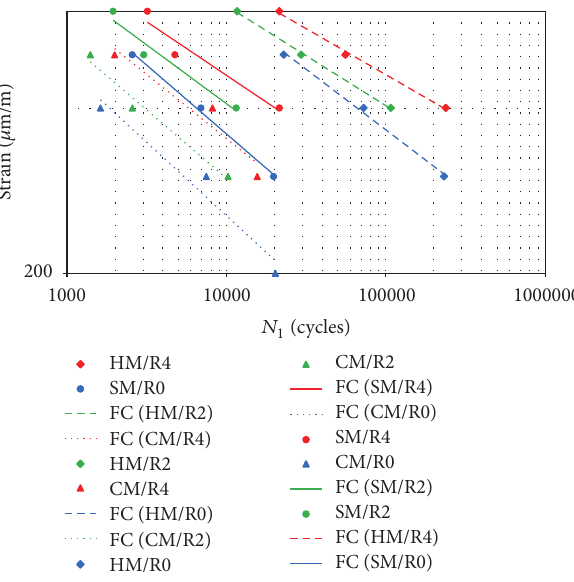
Figure 7: Fatigue life 𝑁 1 versus initial strain: aged